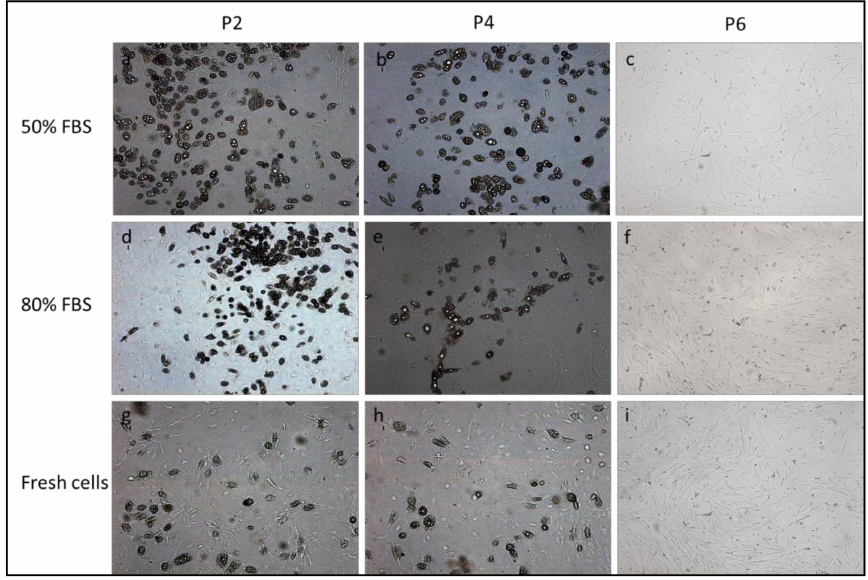
Figure 4. Fat globules appeared in cAD-MSCs, cryopreserved with 10% DMSO–50 and 80% FBS and thawed, cultured with adipogenic differentiation medium at passages P2 ( a , d ) and P4 ( b , e ). No differentiation was observed in the passage P6 ( c , f ). The frozen cells showed the same differentiation potential as fresh cells at each passage ( g , h , i ). A 100 × magnification.